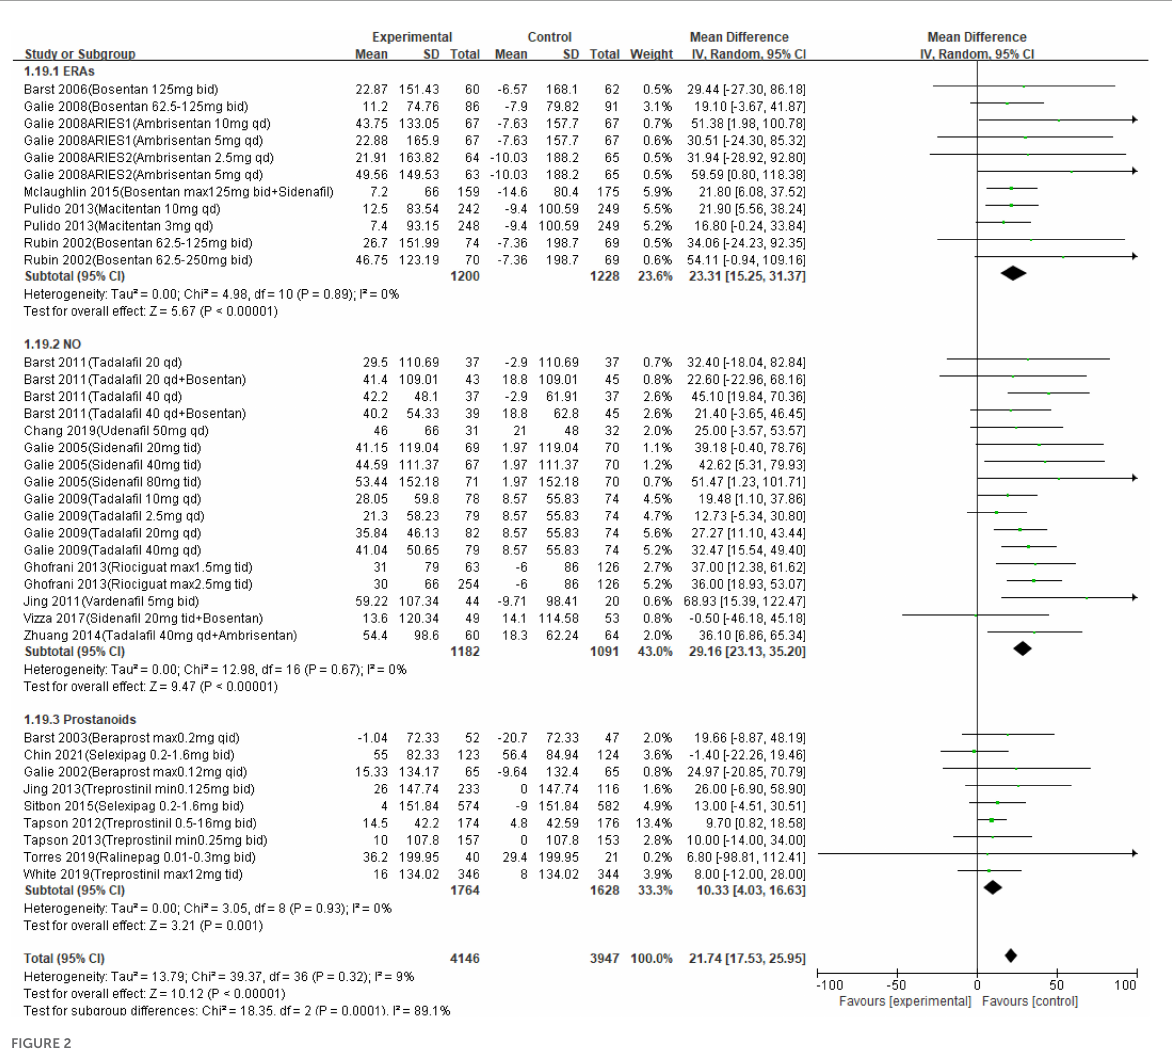
of the quality assessment of all pooled studies are shown in Figure 6